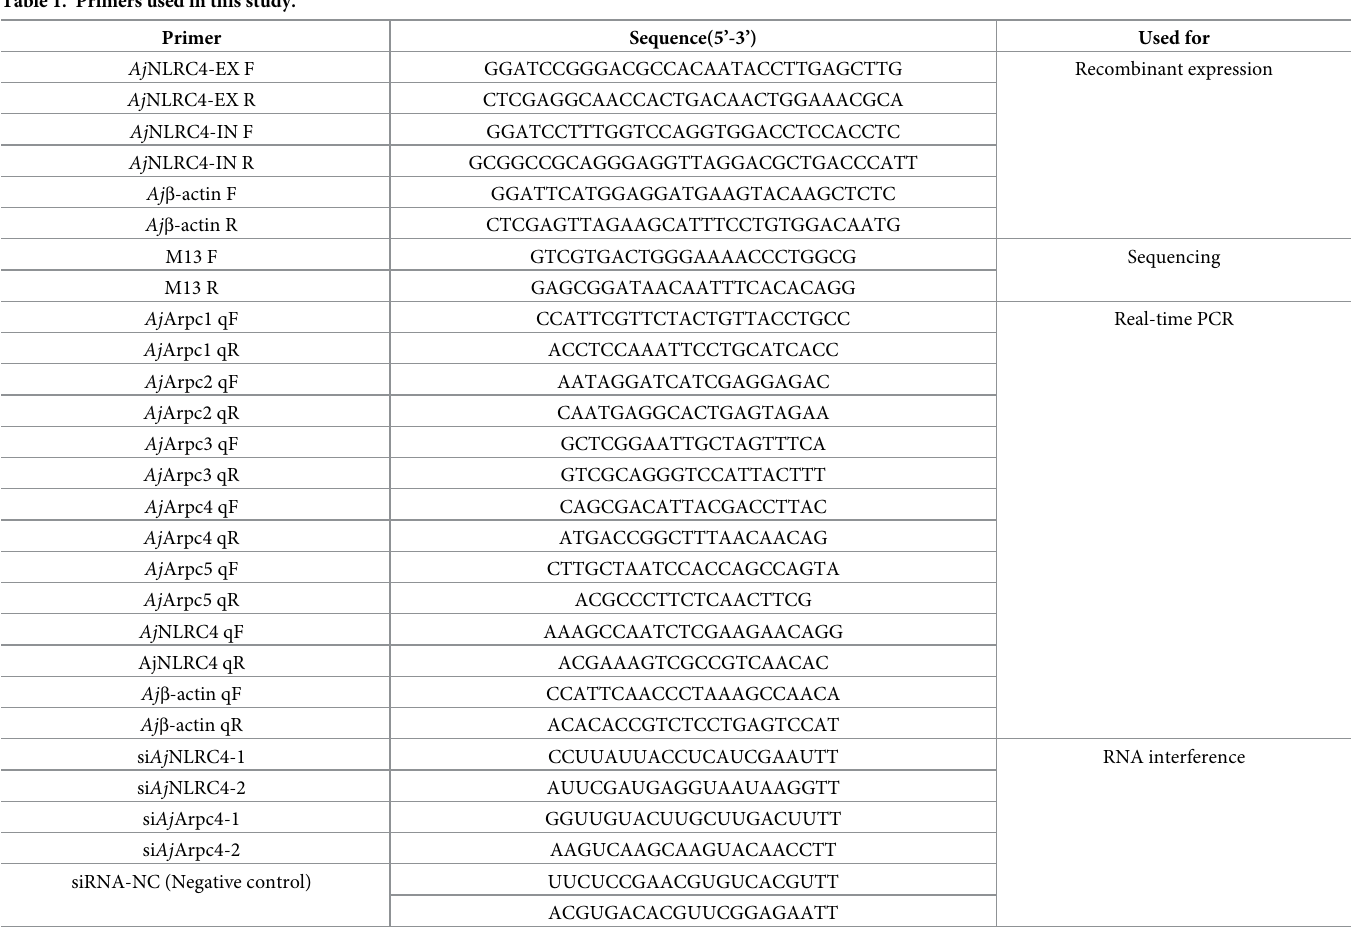
Table 1. Primers used in this